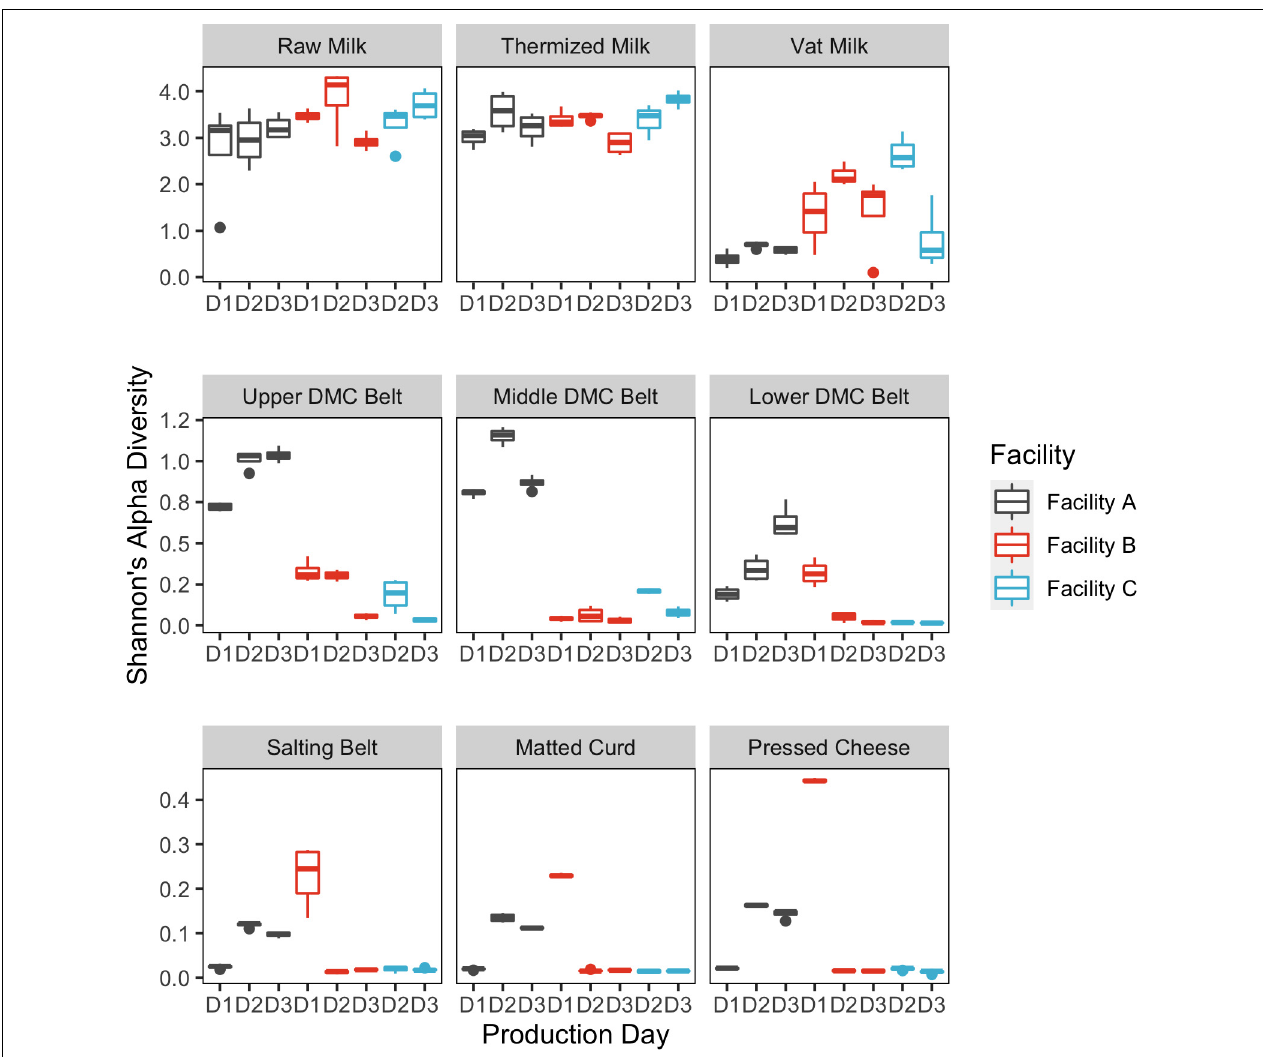
FIGURE 2 | Box plots showing Shannon’s alpha diversity estimates by sample location. Bars are colored by cheesemaking facility. Repeat sampling days within each facility are displayed across the x -axis ( n = 3 Facilities A and B; n = 2 Facility C). Decline in alpha diversity in samples collected post-thermization is partially explained by starter addition which occurs in the